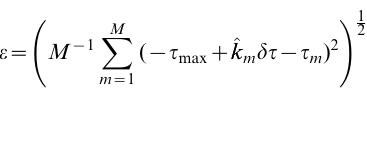
Figure S1 Robustness of single cell mutual information. (A–D) Single cell mutual information for different best frequencies.